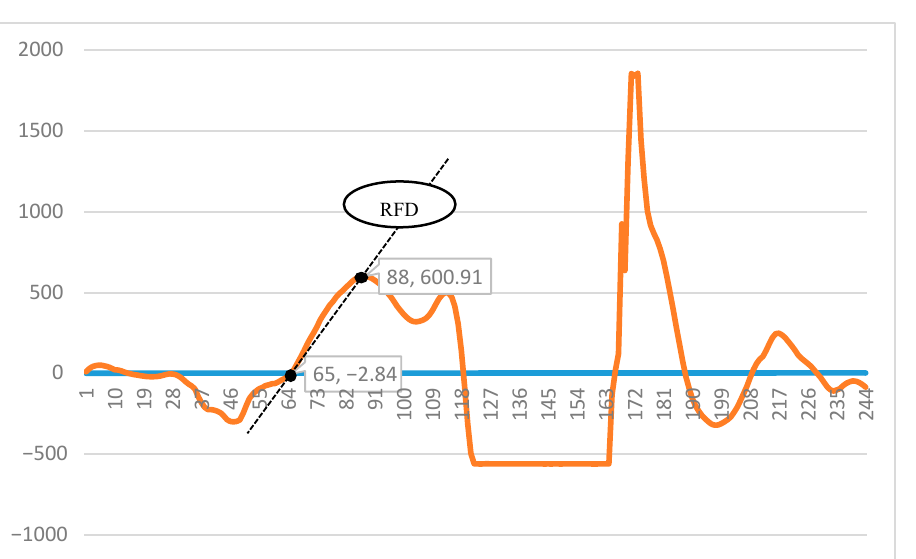
Figure 2. Representation method used to quantify average rate of force development (RFD) from the force–time curve.